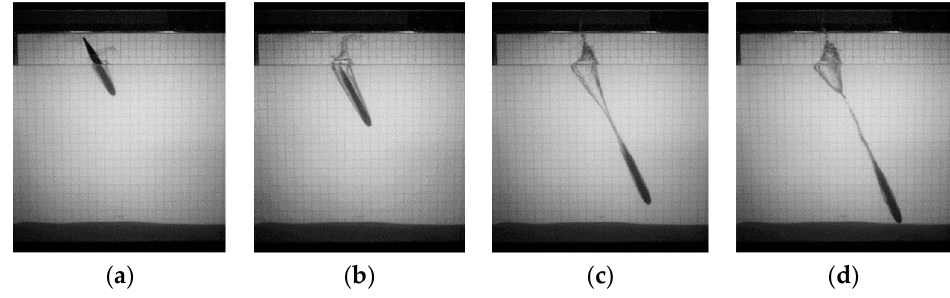
Figure 8. Evolution process of the water cavity upon entry. ( a ) Flow formation. ( b ) Open cavity. ( c ) Cavities closure. ( d ) Cavities collapse.